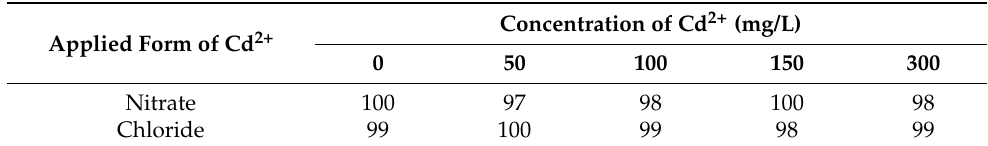
Table 1. Germination percentage (%) of Vicia faba seeds after imbibition with water H 2 O (0) and different concentrations of Cd.